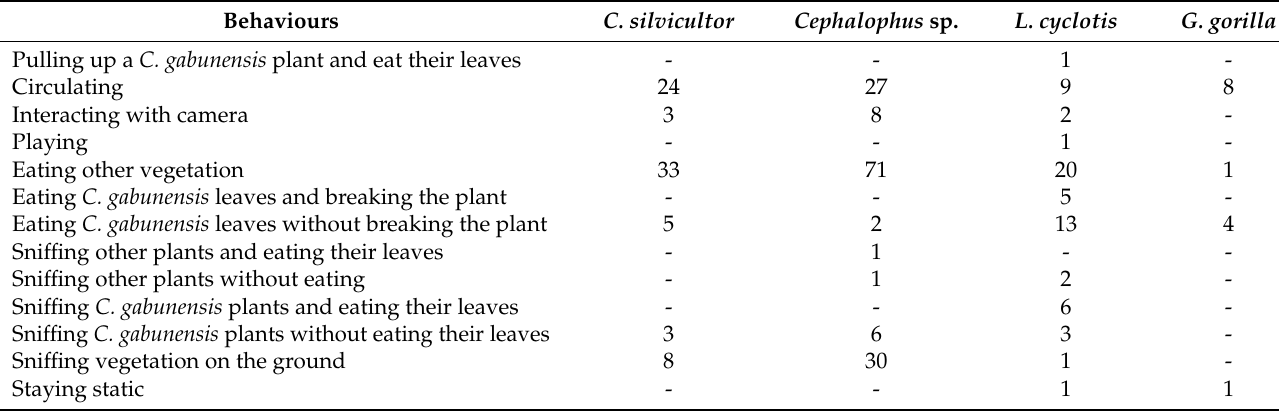
Table A7. List of detected species with their